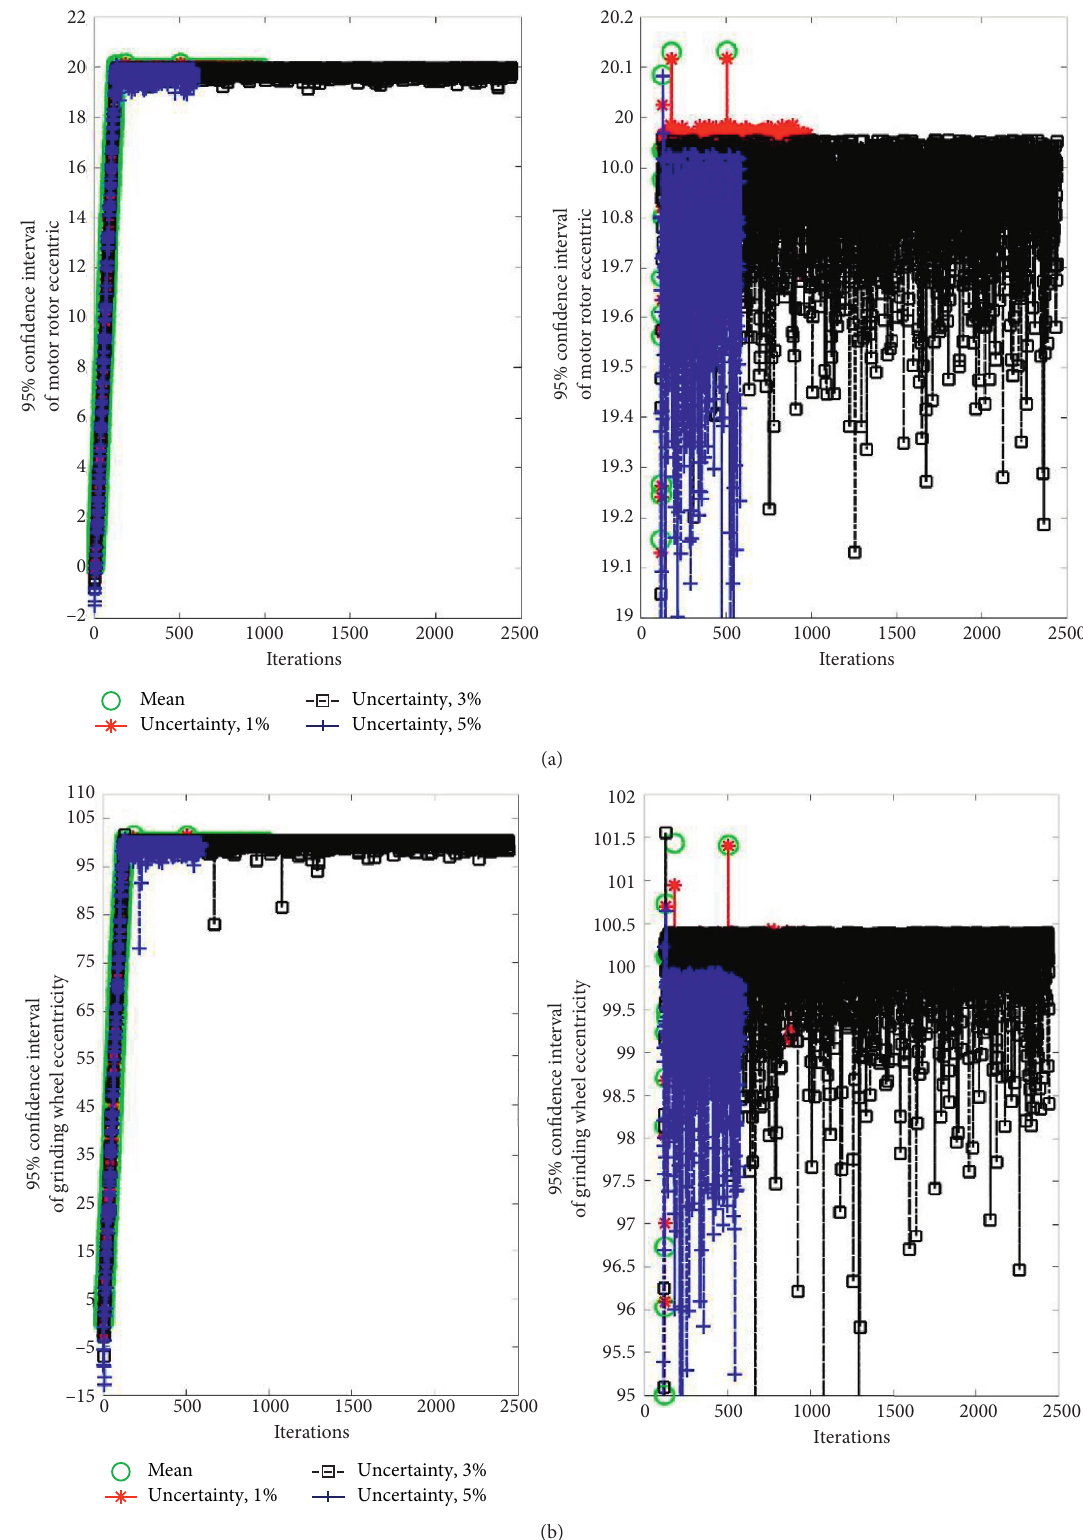
Figure 5: 95% confidence interval iterative process for parameters under three errors. (a) Motor eccentricity. (b) Grinding wheel